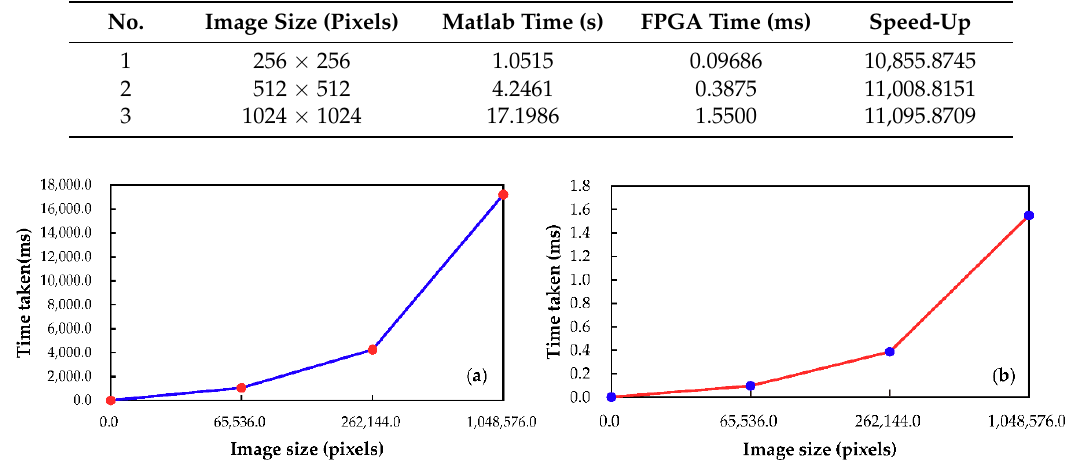
Table 8. Average processing time for RPC orthorectification implementation on Matlab and FPGA.